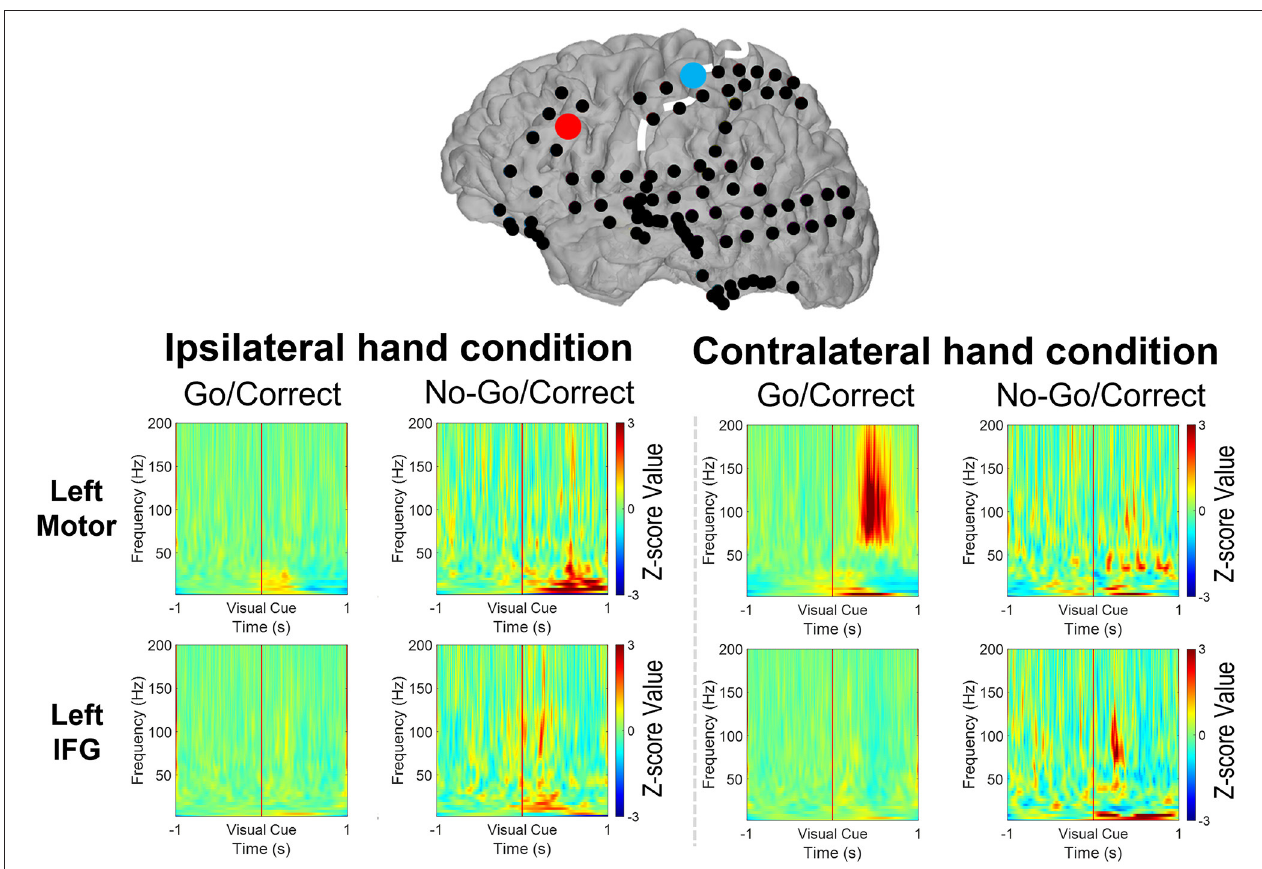
FIGURE 6 | The spectrum revealed the power change over the motor cortex (the blue dot) and the IFG (the right dot) from 1s before to 1s after the visual cues (Go or No-Go) by a 9-year-old boy with a left-side grid implanted. When the right hand was used, the power of the high-gamma band (HG, 70–200Hz) increased with a decreased beta band (12–40Hz) over the motor cortex after visual cues in Go/Correct trials. Increased HG and theta (4–8Hz) power were noted when both the right and left hands were used in No-Go/Correct trials.